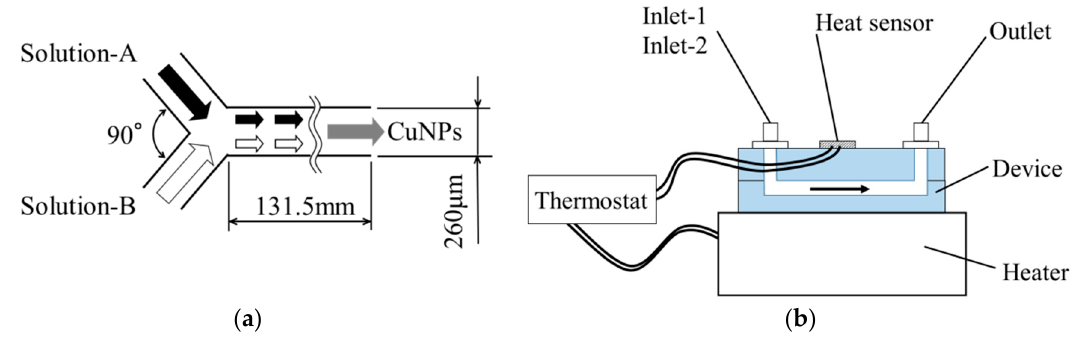
Figure 2. ( a ) Schematic image of a joint section in the microchannel. The length of channel after joint section which mixing of the agents are started is 131.5 mm; ( b ) Experimental setup for the synthesis. Heat sensor was set to the position between inlet and